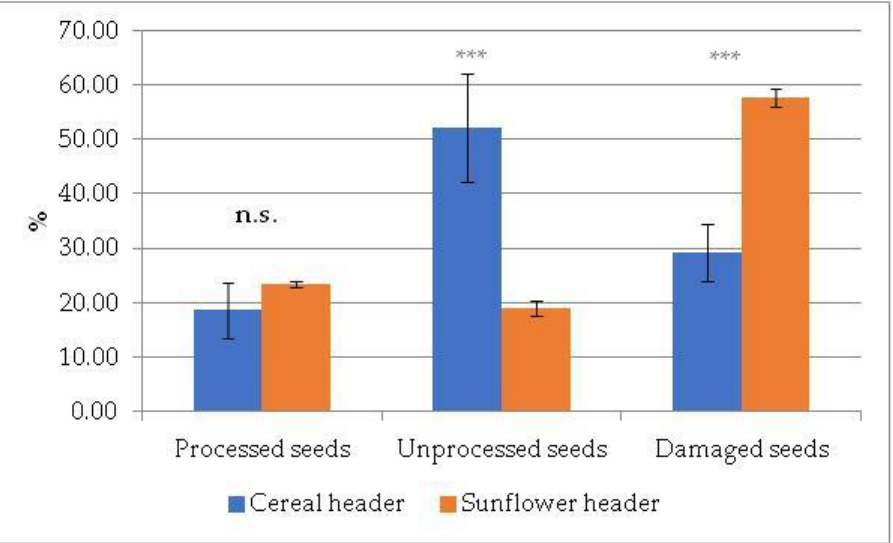
Figure 5. Percentage share of correctly processed seeds, unprocessed seeds, and damaged seeds for both treatments. “***” indicates statistically significant difference at p < 0.001 according to t -test. “n.s.” indicates no significant difference between the treatments according to t -test.